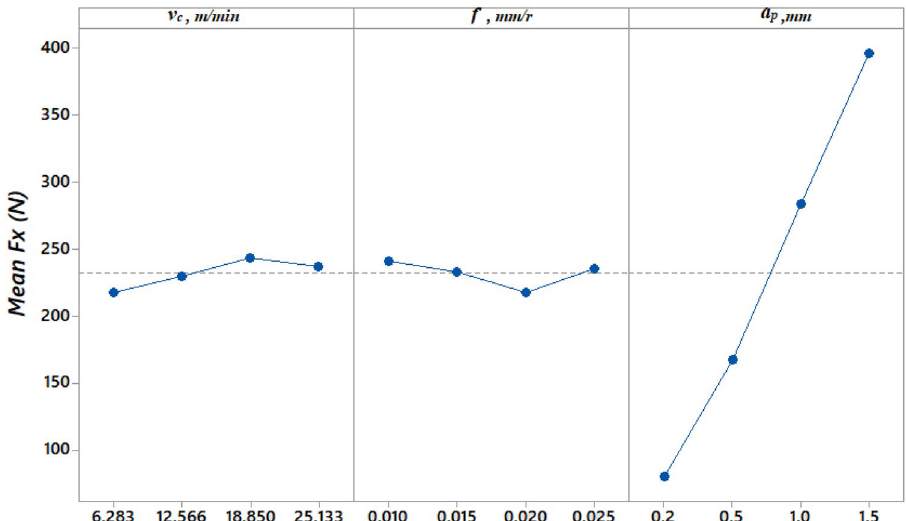
Fig. 10 main effect plot F x cut- ting force SiCp/Al